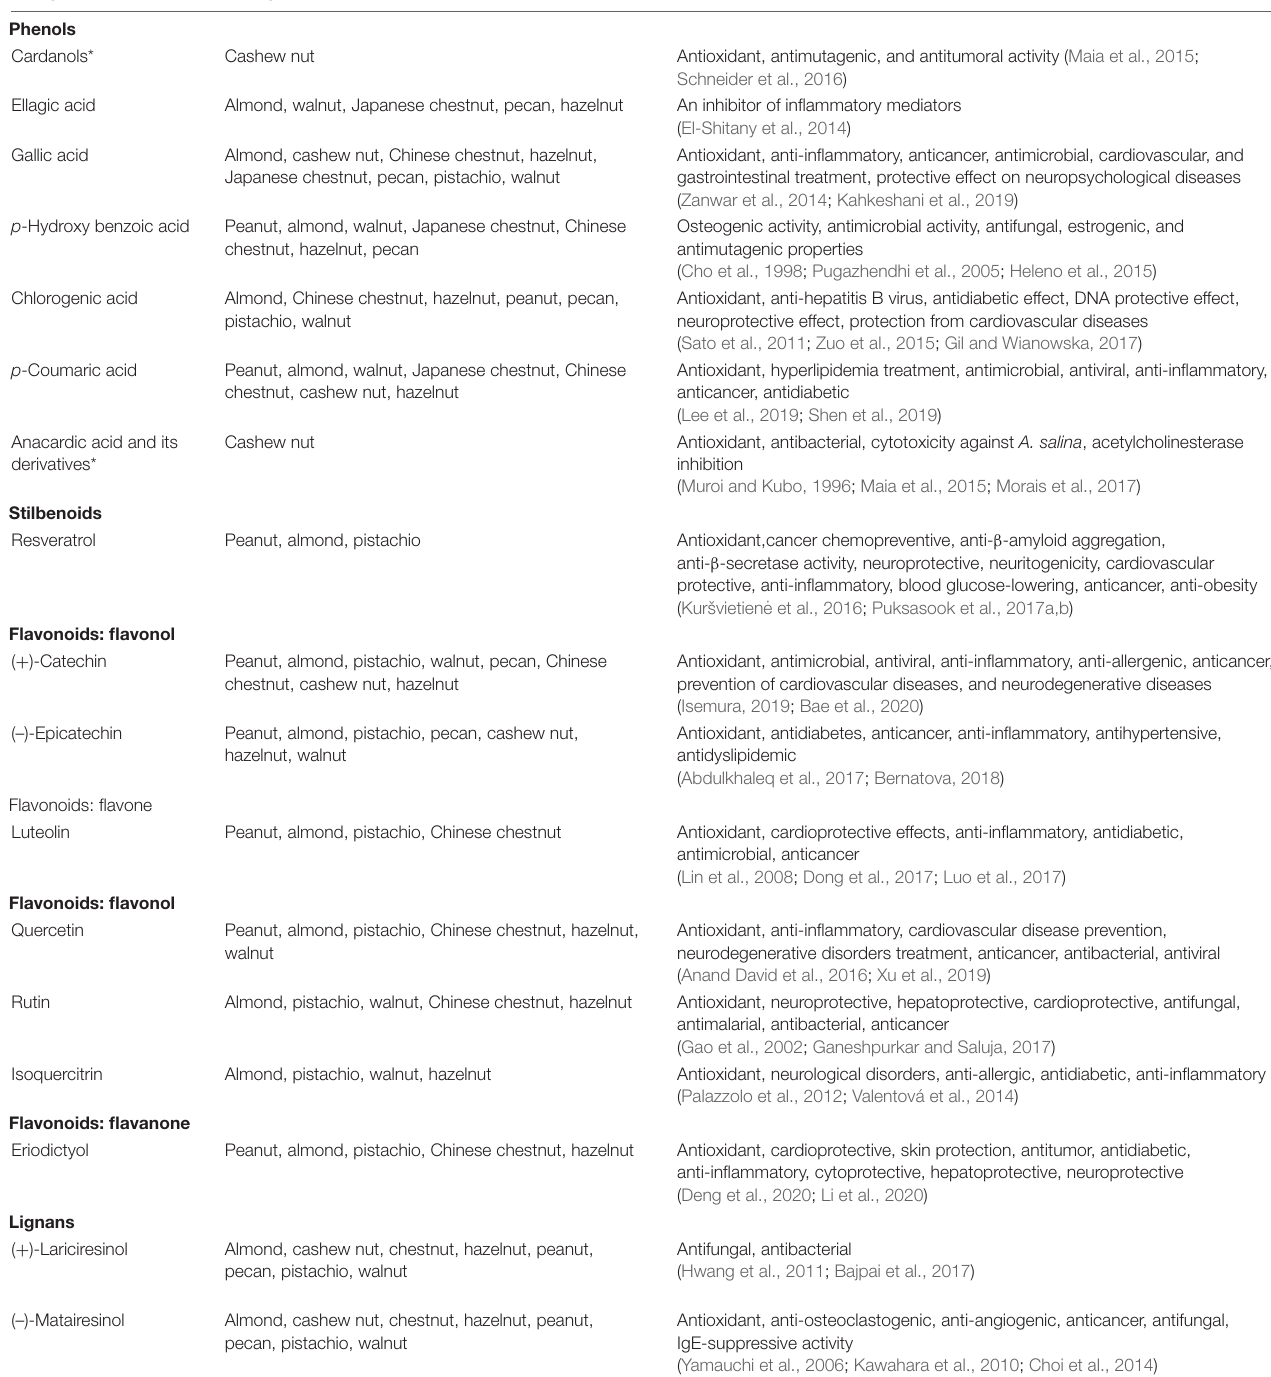
TABLE 2 | Bioactivities of major and specific polyphenolics in nut plant